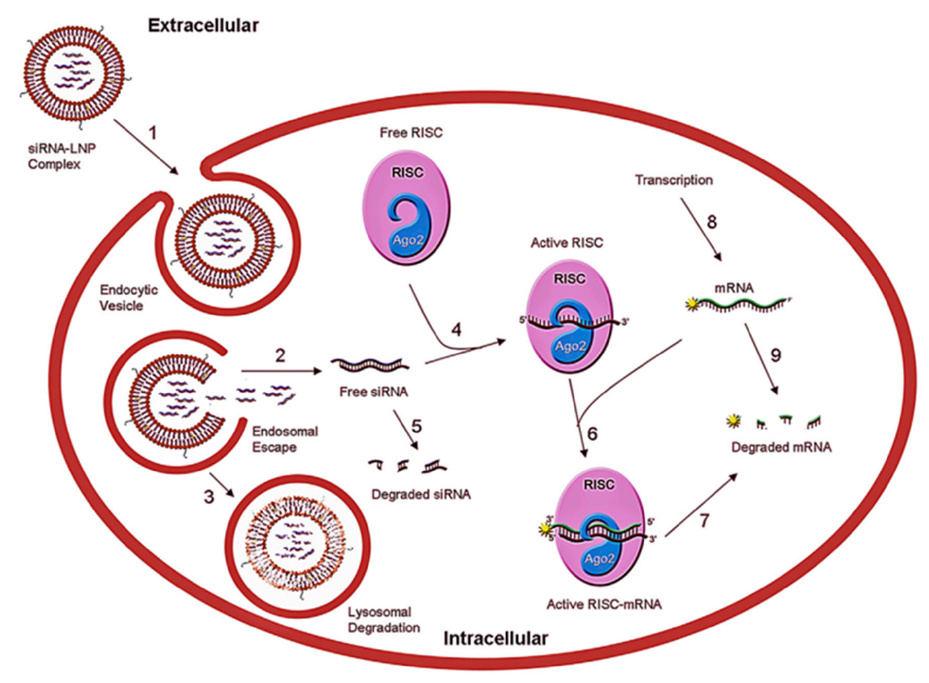
Figure 1. Schematic representation of mechanism of LNP-mediated siRNA delivery into cells resulting in gene silencing. The steps involve (1) LNP crossing the plasma membrane; (2) endosomal escape; (3) lysosomal degradation of LNP; (4) siRNA loading onto RISC; (5) siRNA degradation; (6) active RISC with target mRNA formation; (7) RISC cleaves the target mRNA; (8) mRNA transcription; and (9) mRNA degradation. Adopted from Ref. [28], Mol. Ther. Nucleic Acids 2017.